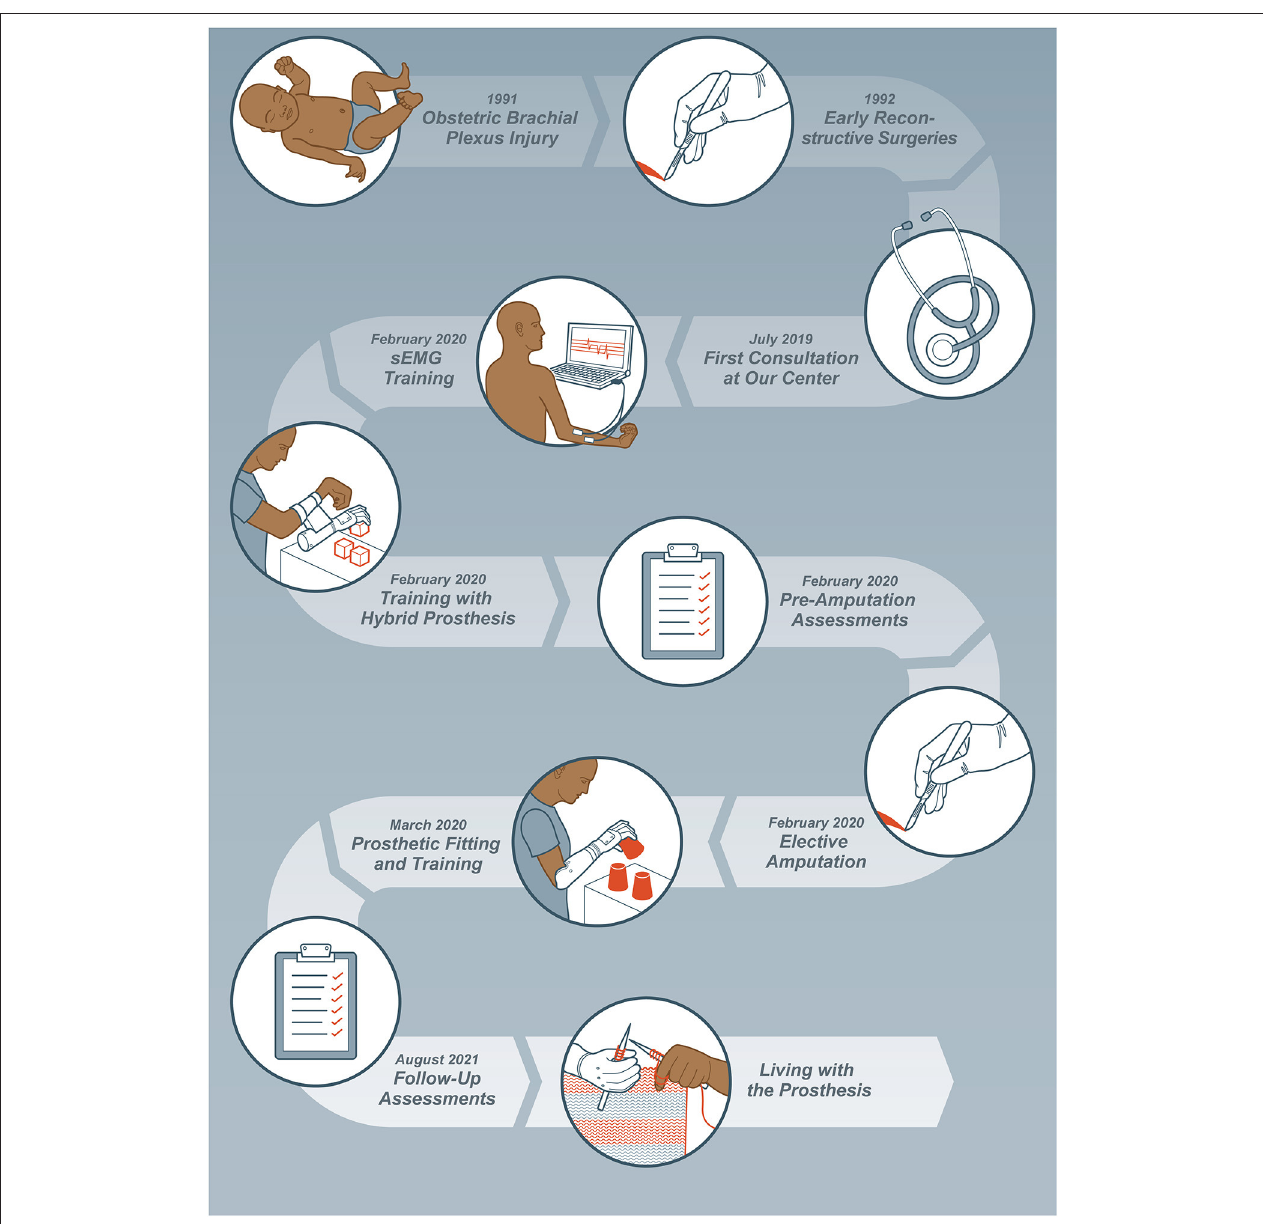
FIGURE 1 | Timeline of the patient undergoing bionic